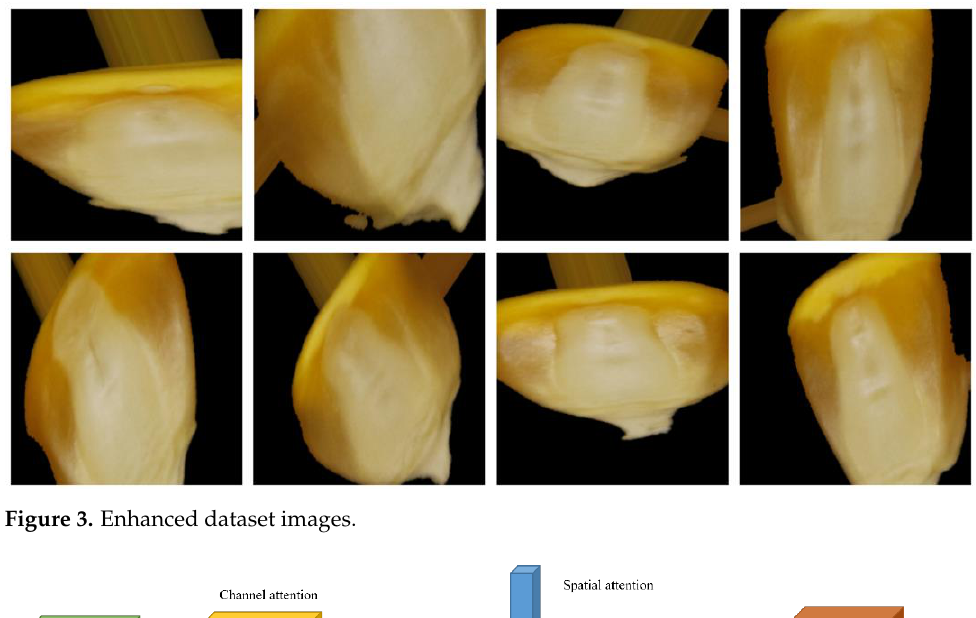
Figure 3. Enhanced dataset images. Table 1. Dataset of maize seeds (double-sided mixture).